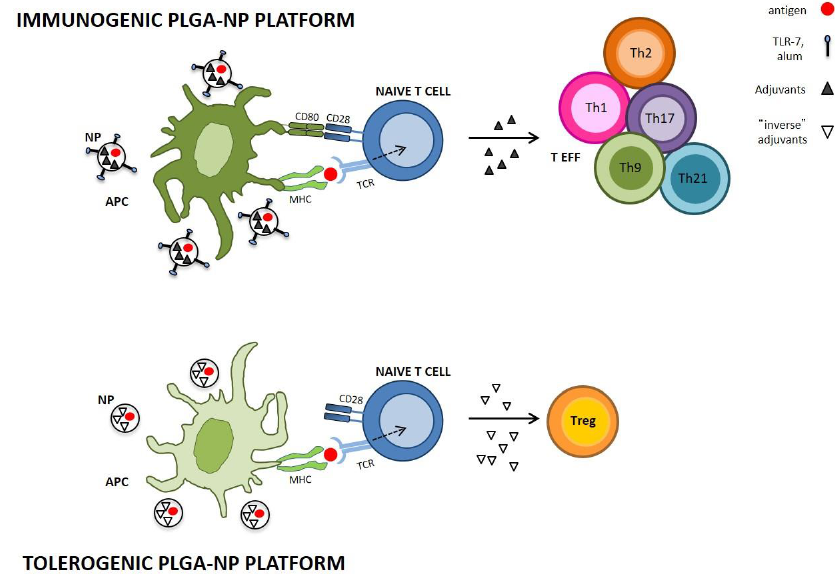
Figure 2. Immunogenic and tolerogenic PLGA-NP platforms. Immunogenic PLGA-NPs may include standard adjuvants such as alum or Toll-like receptor (TLR-7) agonists, capable to activate APC